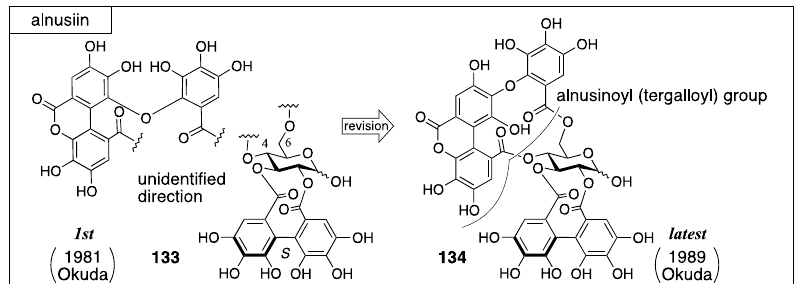
Figure 47. The transition of the structure of alnusiin.